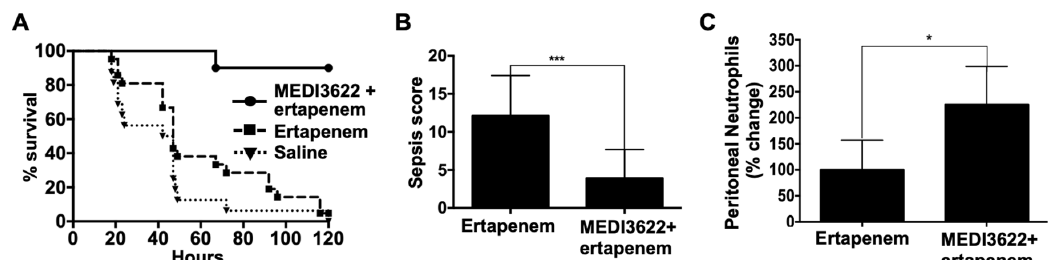
Figure 2. Effects of MEDI3622 and antibiotic treatment on sepsis response. ( A ) All mice were subjected to CLP (18G needle). Separate groups of mice were ip administered MEDI3622 (15 mg/kg) 24 h prior to sepsis and ertapenem (75 mg/kg) ip at 6, 24, and 48 h post-CLP; ertapenem ip at 6, 24, and 48 h post-